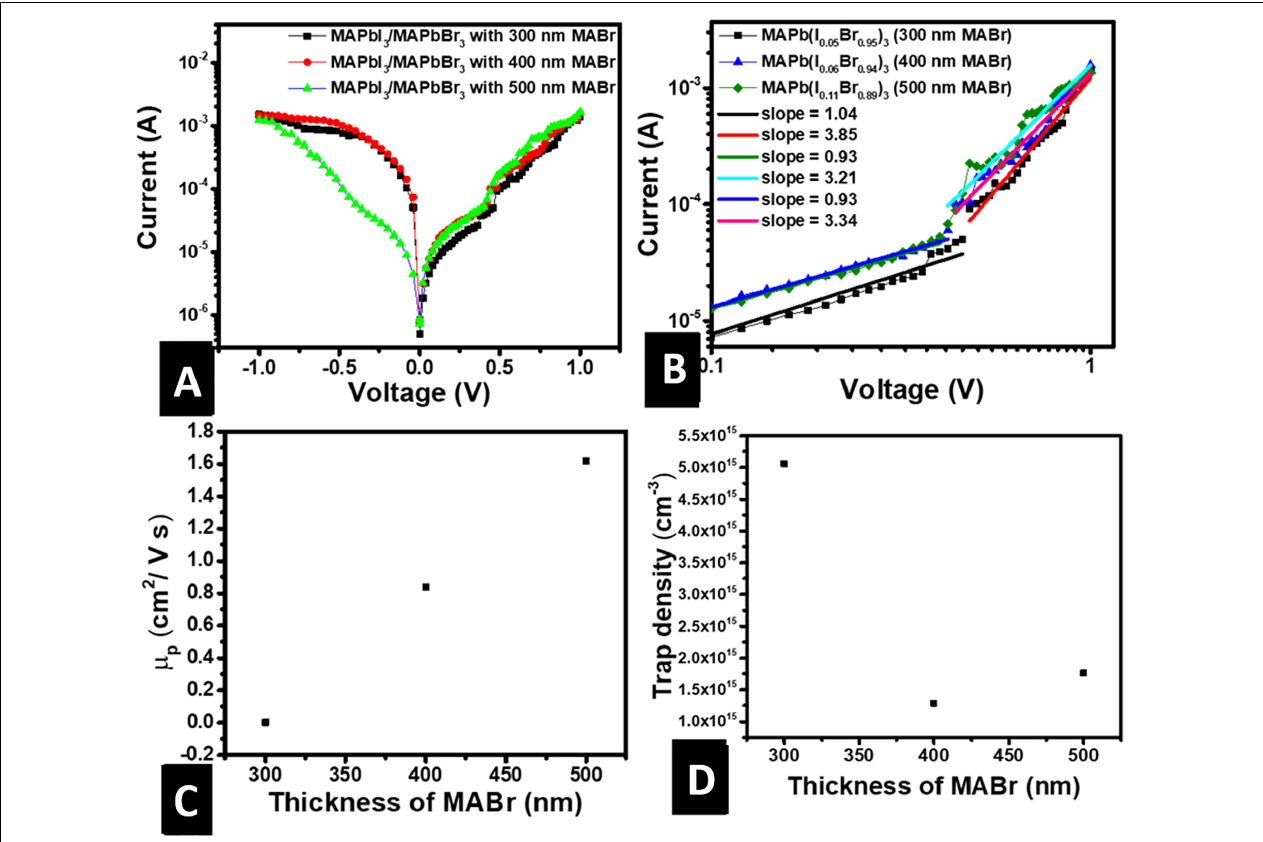
FIGURE 5 | Dark current-voltage characteristics for FTO/MAPb(I 1 − x Br x ) 3 /Au from which the mobility and trap density are extracted using SCLC method. (A) Semi-log current-voltage characteristic showing ohmic contact, (B) double-log current-voltage characteristic for the calculation of trap density and mobility, (C) mobility of charge carriers in MAPb(I 1 − x Br x ) 3 vs. thickness of MABr, (D) trap density in MAPb(I 1 − x Br x ) 3 vs. thickness of